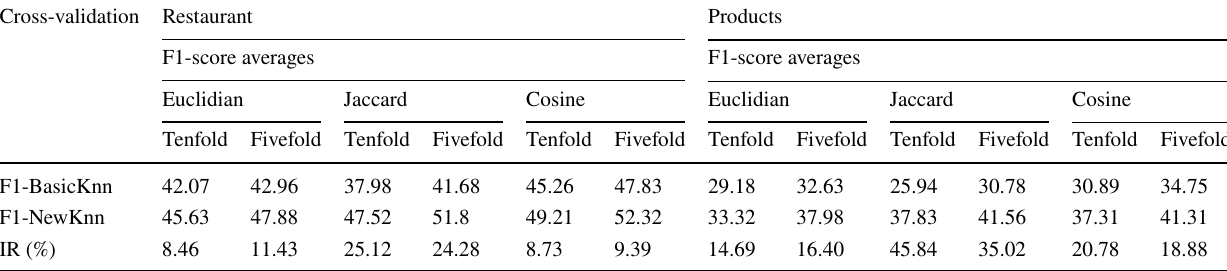
Table 2 Averages of improvement rates of NewKNN over BasicKNN on both datasets for three distances and with fivefold and tenfold cross- validation Cross-validation Restaurant